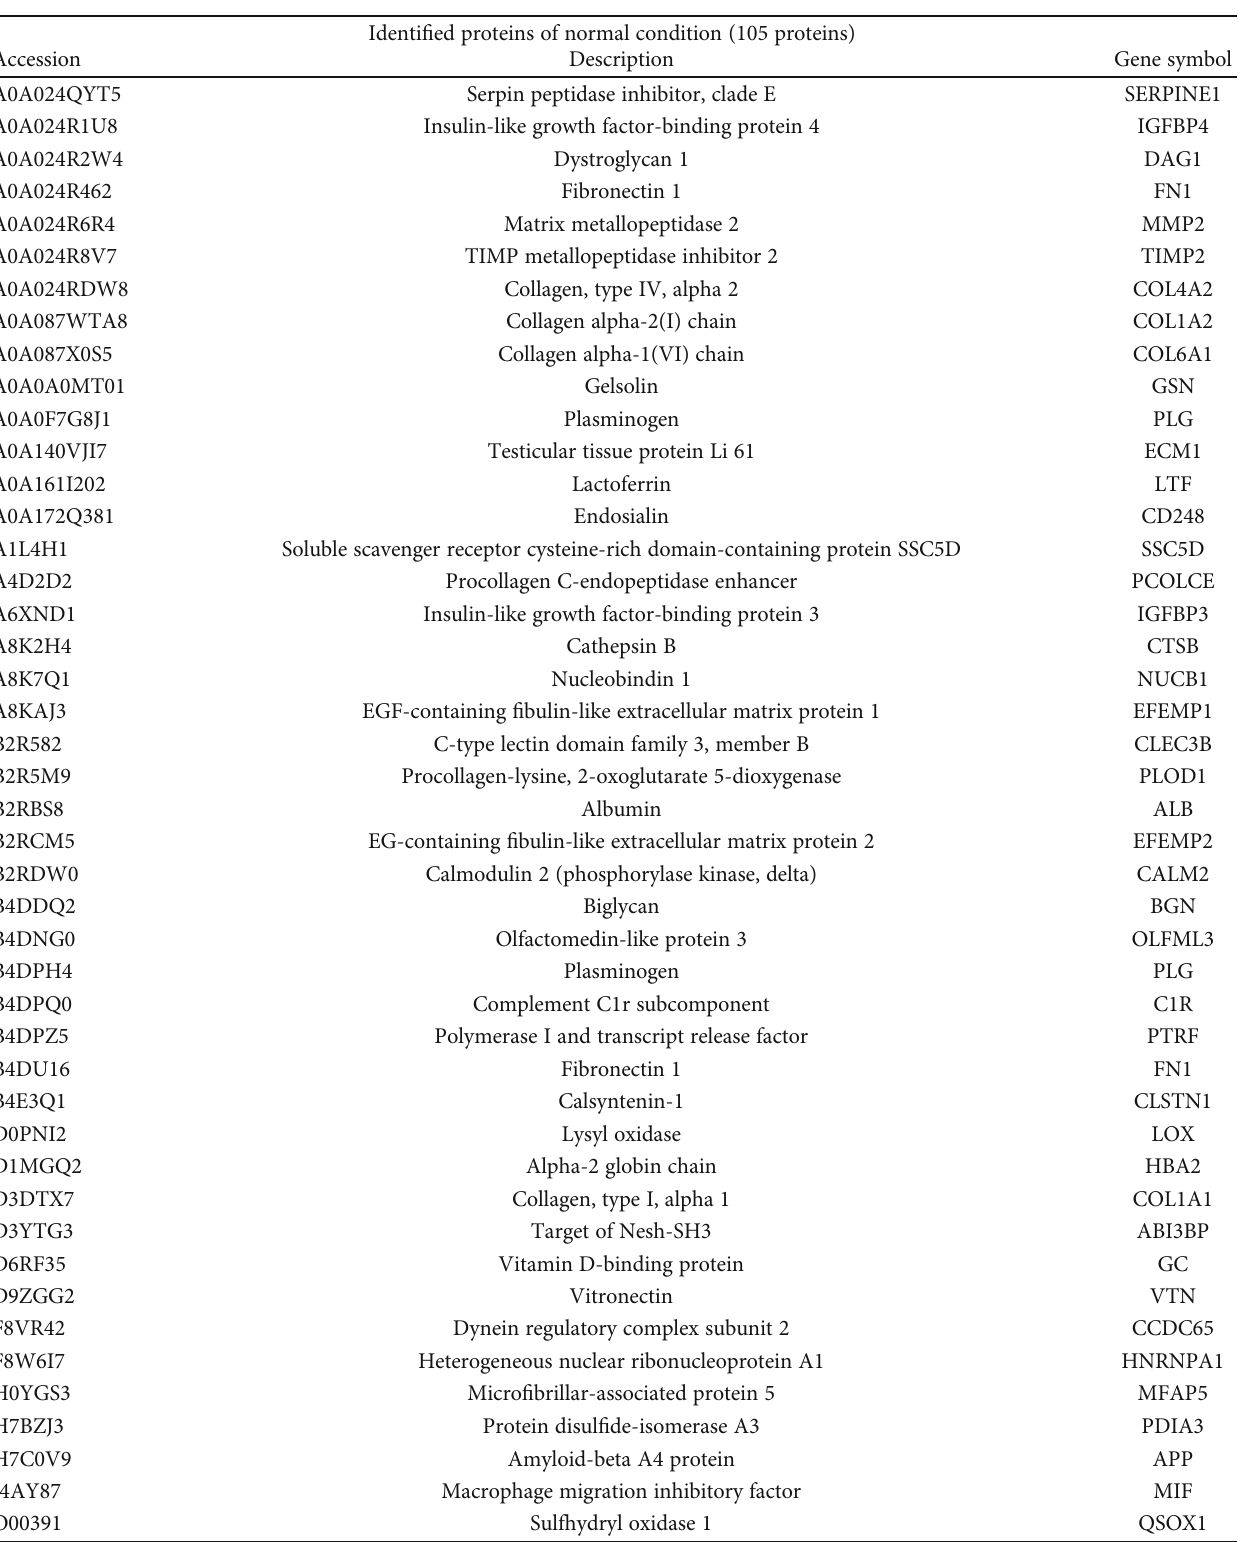
Table 1: The list of commonly secreted proteins identi fi ed by all mesenchymal stem cells (MSCs) under normal and in fl ammatory